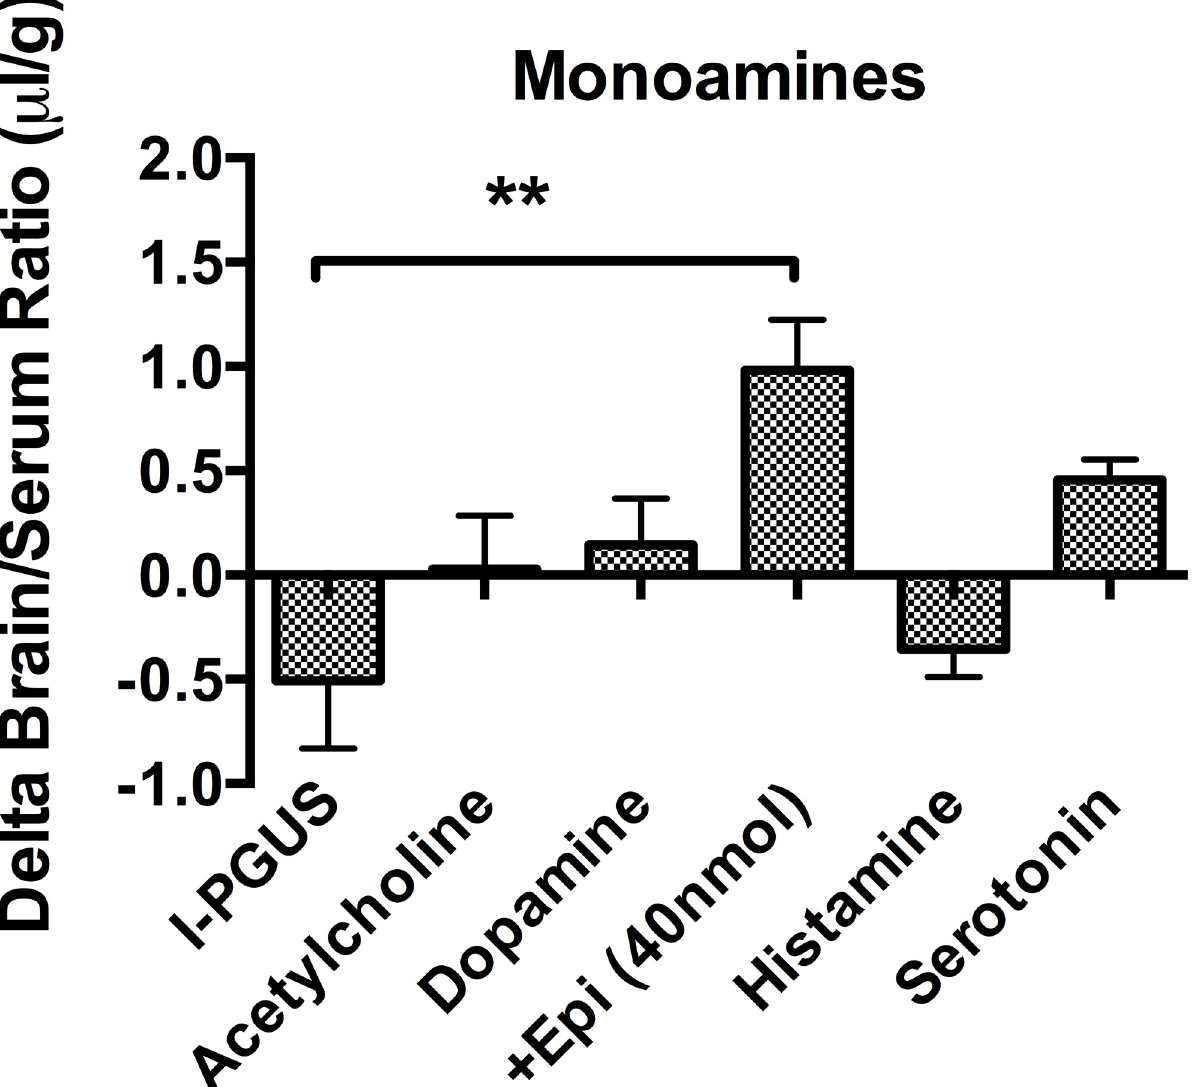
Fig 2. Effect of monoamines and acetylcholine on I-PGUS uptake. Only epinephrine enhanced BBB penetration. ** P < 0.01; n =